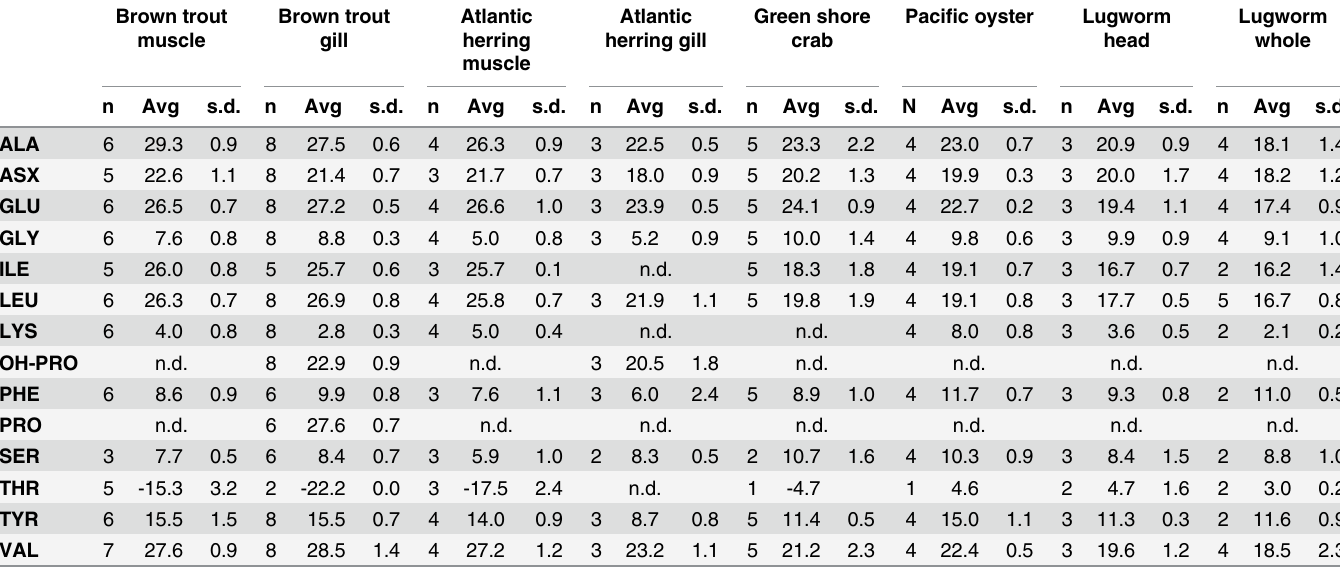
Table 2. δ 15 N values of amino acids. Avg and s.d. = average and standard deviation of n injections. ALA = alanine; ASP = aspartic acid; GLU = glutamic acid; GLY = glycine; ILE = isoleucine; LEU = leucine; LYS = lysine; OH-PRO = hydroxy-proline; PHE = phenylalanine; PRO = proline; SER = serine; THR = threonine; TYR = tyrosine; VAL = valine.